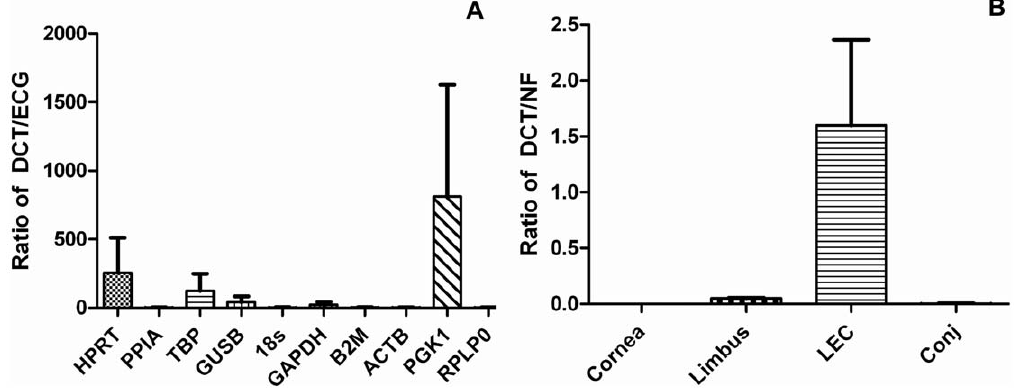
Figure 3. Normalised gene expression of Dopachrome Tautomerase (DCT) in ocular surface regions. Graph A shows the normalised expression of Dopachrome Tautomerase (DCT) in OS epithelial regions using the 10 individual ECGs studied. As seen in graph A, DCT was found to have highly variable expression with individual endogenous control genes. Graph B shows normalised expression of DCT using the normalisation factor (NF) as determined in this study. Normalised expression of DCT with NF is stable and some expression of DCT is also noted in limbus.